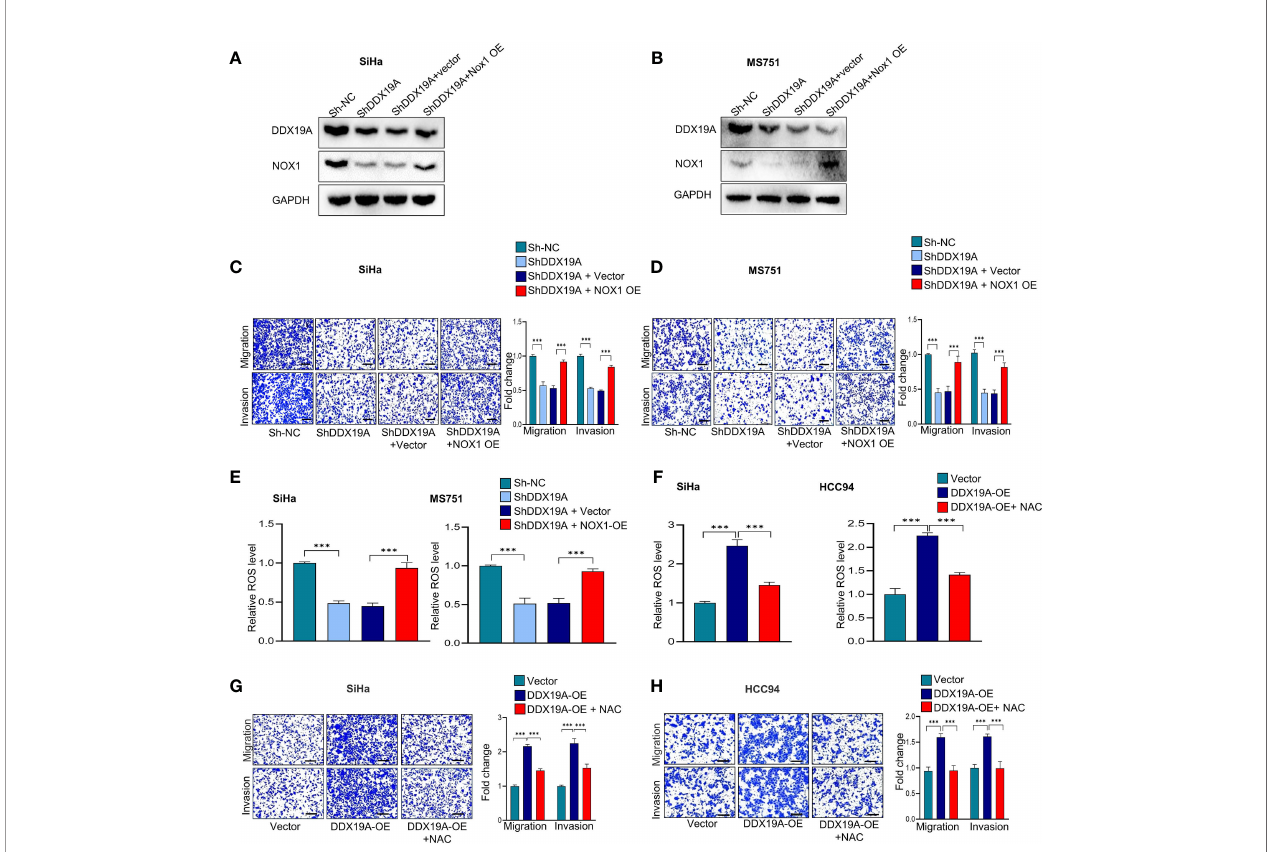
FIGURE 5 | The NADPH oxidase 1 (NOX1)/reactive oxygen species (ROS) axis exerts a pro-metastasis effect downstream of DEAD-box helicase 19A (DDX19A). (A, B) Western blot was employed to evaluate the overexpression ef fi cacy of NOX1 proteins in DDX19A knockdown cell lines (SiHa and MS751) (n = 3). (C, D) Cell migration assay and Matrigel invasion assay were performed to evaluate whether restoring NOX1 expression could increase cellular migration and invasion in DDX19A knockdown cell lines (SiHa and MS751) (n = 3). (E) The 2 ′ ,7 ′ -dichlorodihydro fl uorescein diacetate (DCFH-DA) fl uorescence assay was performed to investigate whether NOX1 overexpression weakens the increase of ROS production induced by DDX19A knockdown in SiHa and MS751. (F) The DCFH-DA fl uorescence assay was used to examine the ROS level in DDX19A-overexpressing cell lines (SiHa and HCC94) treated with or without N-acetylcysteine (NAC) (ROS inhibitor). (G, H) Cell migration assay and Matrigel invasion assay were performed to investigate whether NAC treatment could recover cell migration and invasion ability in DDX19A-overexpressing cell lines (SiHa and HCC94) (scale bar: 200 m m). Results represent three independent experiments. The results were shown as mean ± SD, *** p < 0.001 by two-tailed Student ’ s